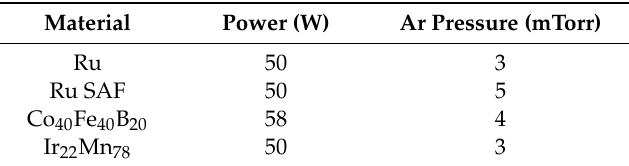
Table 1. Magnetron sputtering